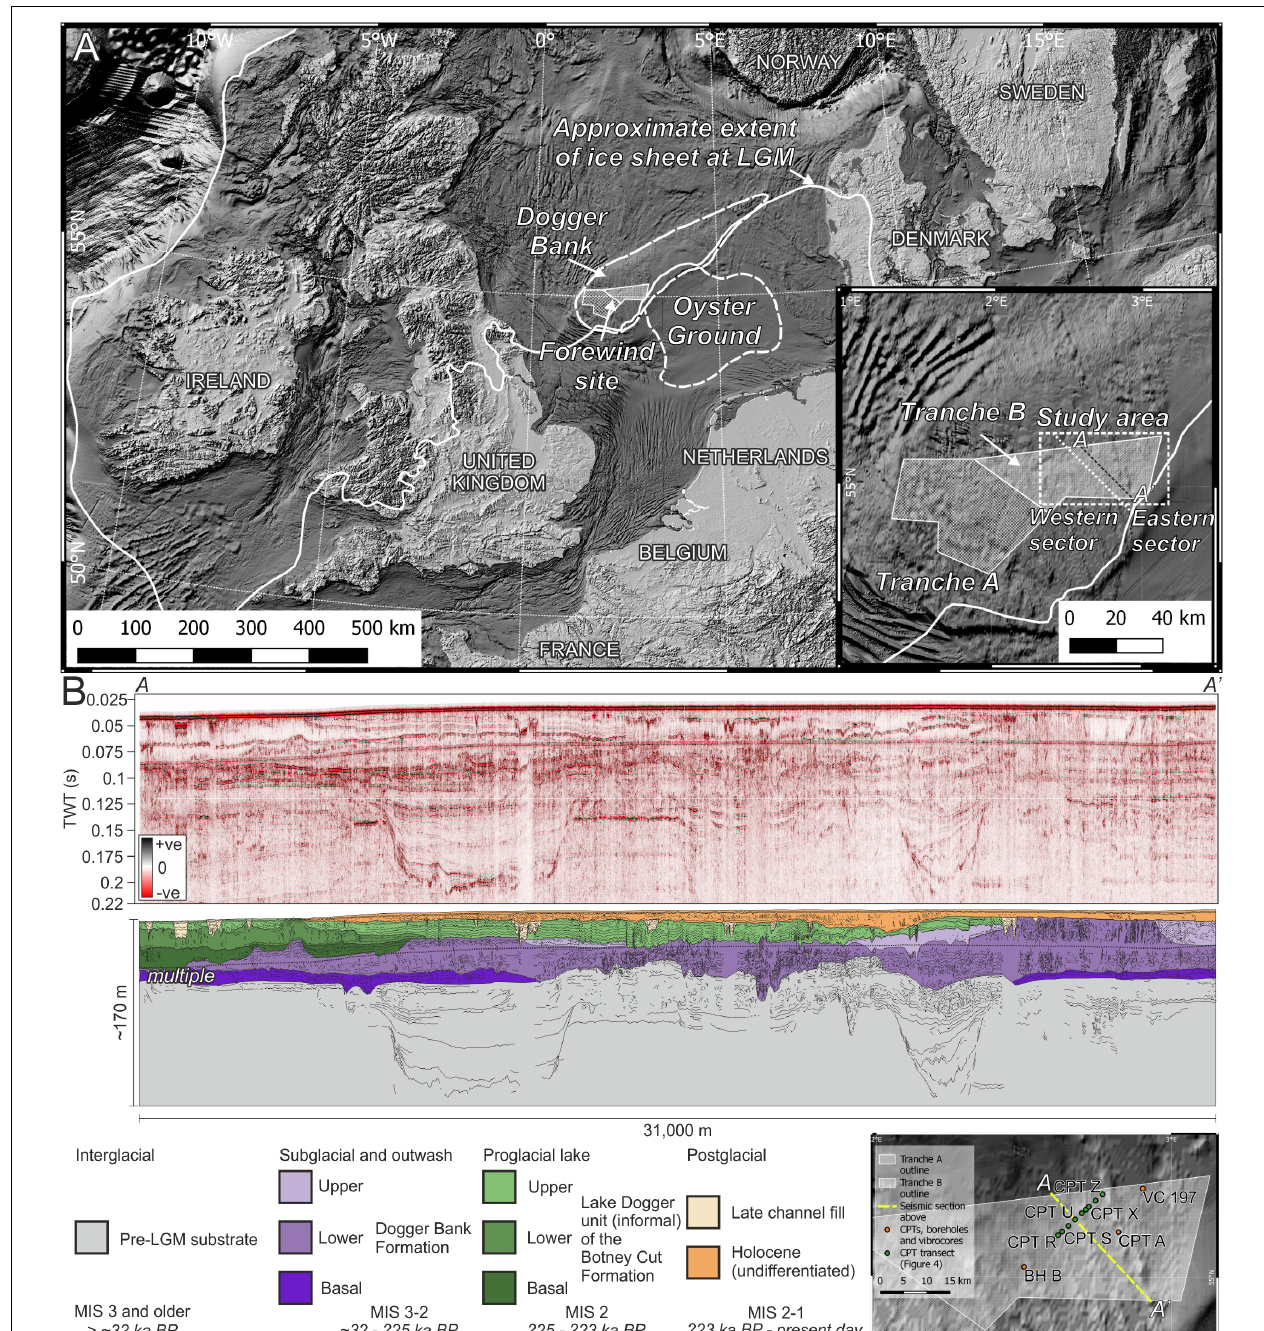
FIGURE 1 | (A) Location of Dogger Bank in the southern North Sea showing the location of the Forewind offshore wind project. Inset shows Tranches (A,B) of the Forewind project, and the area of focus for this study. Ice sheet extent combined from this study and Sejrup et al. (2005), Bradwell et al. (2008), and Ballantyne (2010). Bathymetry data: GEBCO (https://www.gebco.net). (B) Stratigraphic section through Dogger Bank showing the relationship between the pre-MIS 2 stratigraphy, Dogger Bank Formation glacial sediments, Botney Cut Formation proglacial lake sediments, and subsequent Late Pleistocene and Holocene sediments. Stratigraphy compiled from Cotterill et al.